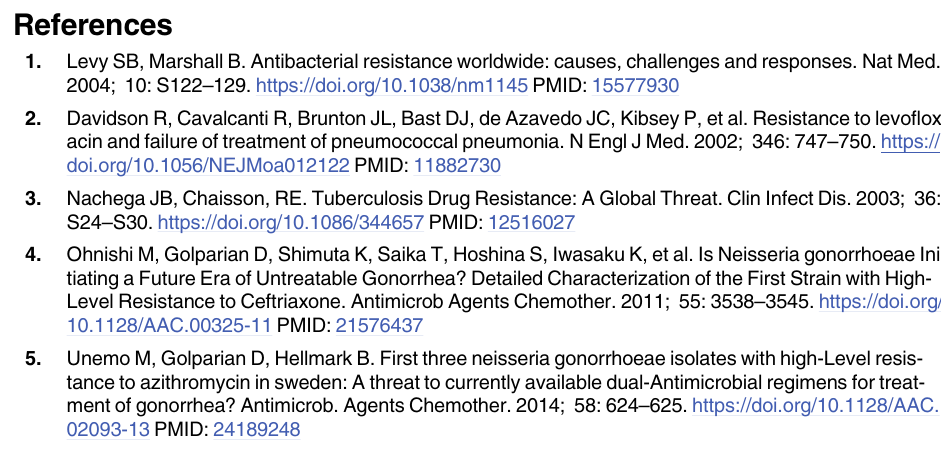
S2 Table. Experimental data from the tetracycline half-life experiments. (DOCX) S3 Table. Full experimental data for the validation biological experiments. (DOCX) S1 Fig. Plot of bacterial density in a host over time with no